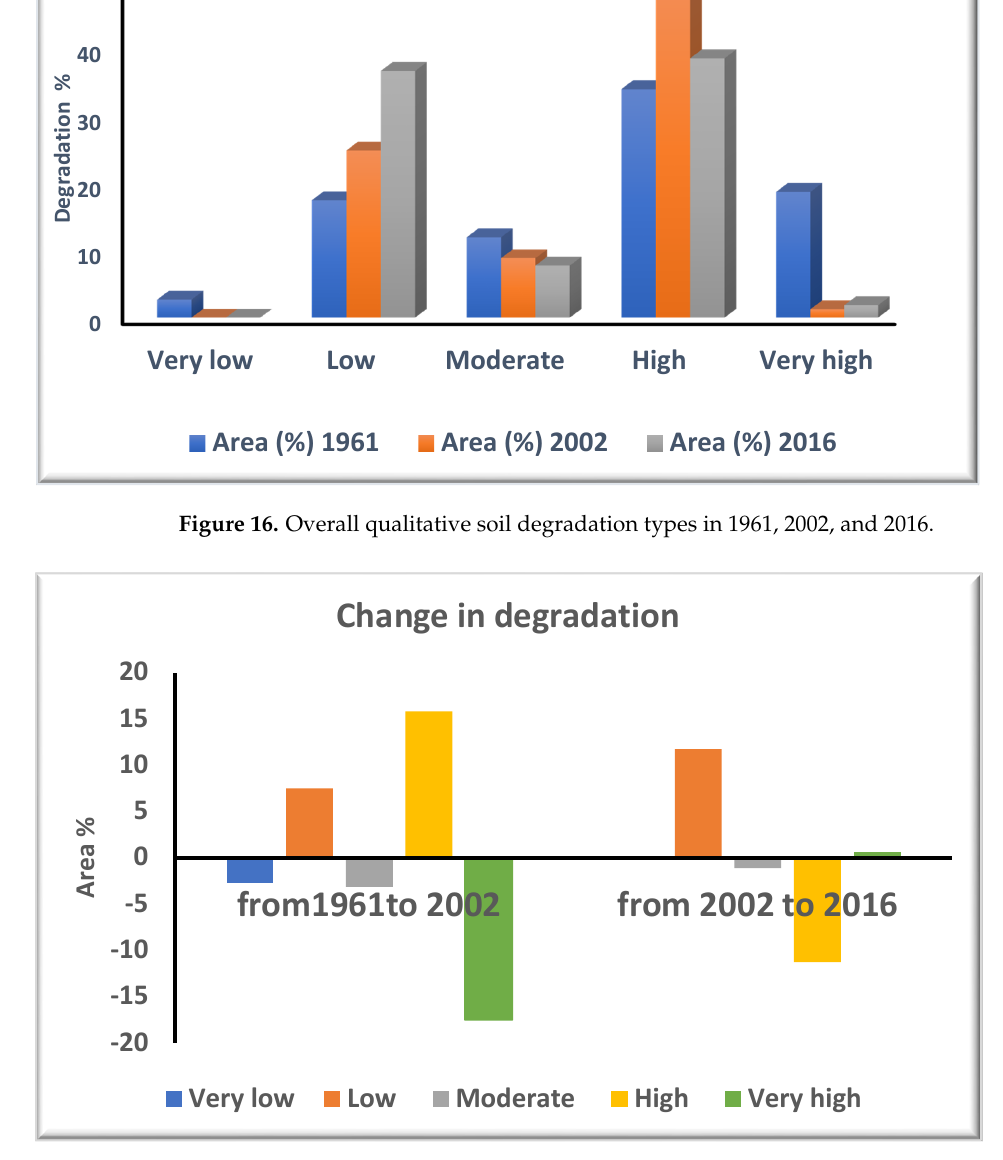
Figure 17. Overall qualitative soil degradation change in 1961, 2002, and 2016.